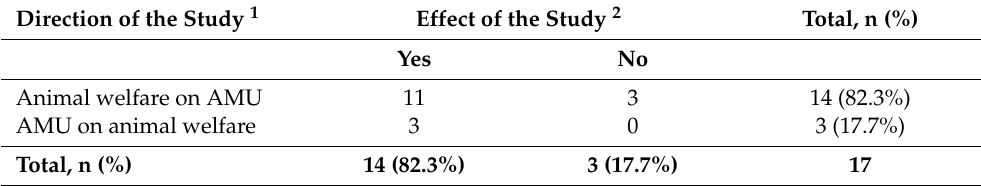
Table 7. Number and percentage of publications by direction and effect of the study. Direction of the Study 1 Effect of the Study 2 Total, n (%) Yes No Animal welfare on AMU AMU on animal welfare Total, n